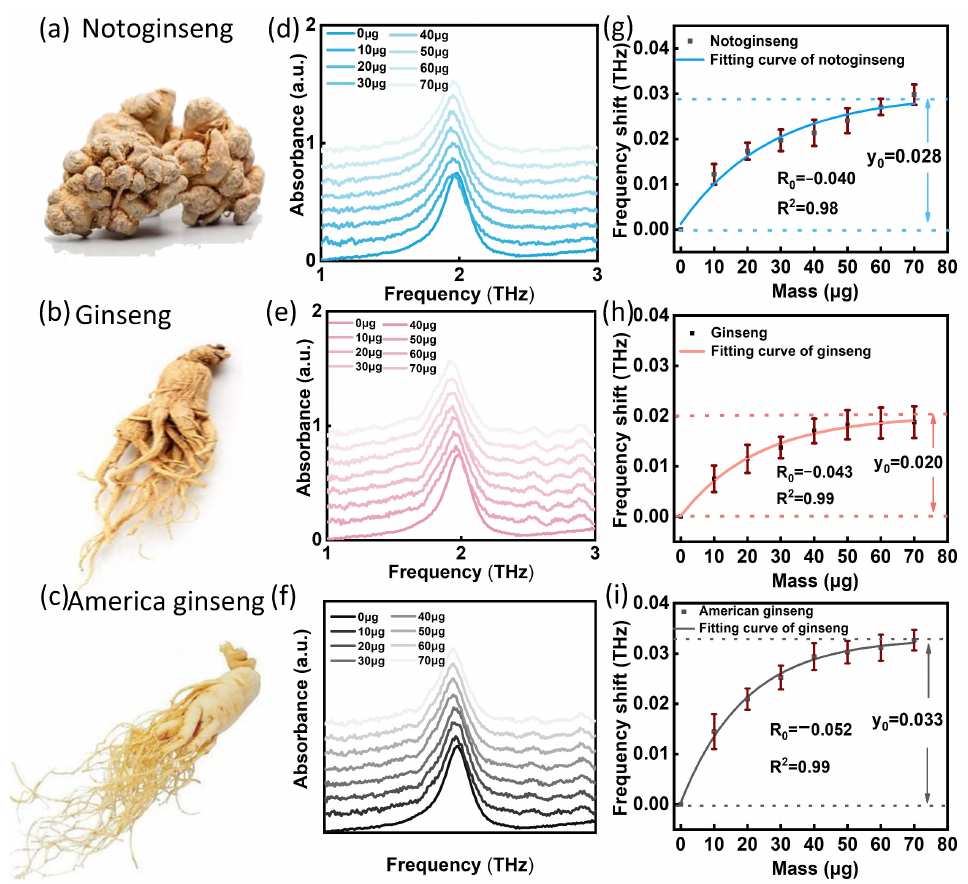
Figure 6. Experimental results of THz SPR biosensor for notoginseng, ginseng and American ginseng. ( a – c ) Sample images. ( d – f ) Test results of notoginseng, ginseng and American ginseng on THz SPR biosensor. ( g – i ) Corresponding frequency shift of mass function of notoginseng, ginseng and American ginseng. Each data set is marked with a standard deviation. Table 1. Parameters values corresponding to the fitting curves of notoginseng, ginseng and Ameri ‐ can ginseng.